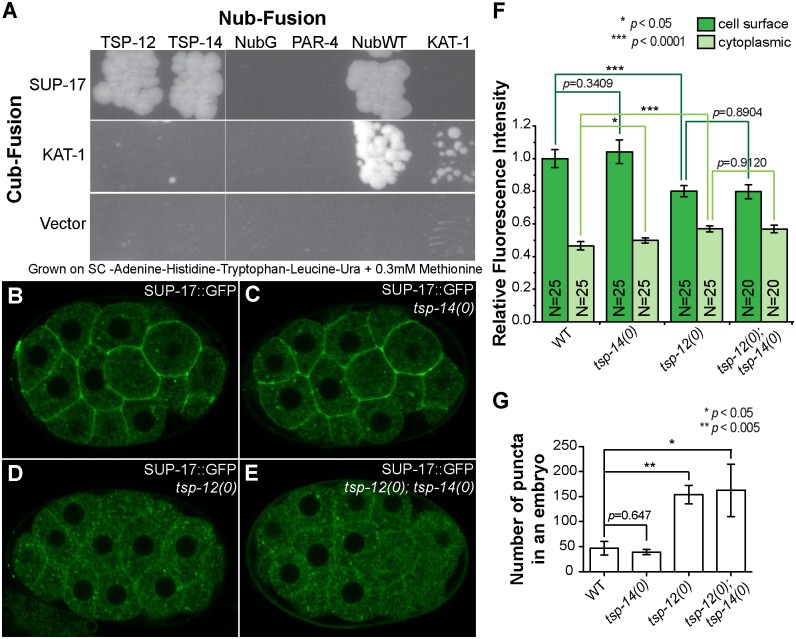
TSP-12 binds to and promotes the cell surface localization of SUP-17.(A) Mating-based split ubiquitin yeast-two-hybrid assay showing that SUP-17 can bind to TSP-12 and TSP-14. (B-E) Confocal images showing the localization of endogenously-tagged SUP-17::GFP in WT (B), tsp-14(0) (C), tsp-12(0) (D) and tsp-12(0); tsp-14(0) (E) backgrounds. (F) Quantification of relative fluorescence intensity of cell surface and cytoplasmic SUP-17::GFP in WT and various mutants (see Materials and Methods). A total of 20 or 25 cells, five cells/30-cell stage embryo, was measured. The mean cell surface fluorescence intensity in WT embryos is normalized to 1.0. Error bars represent 95% confidence intervals (CI) for the normalized mean fluorescence intensity. (G) Quantification of the number of intra-cellular puncta in embryos of WT and various mutants (see Materials and Methods). Three to five 30-cell stage embryos were measured. Error bars represent standard error of the mean (SEM).